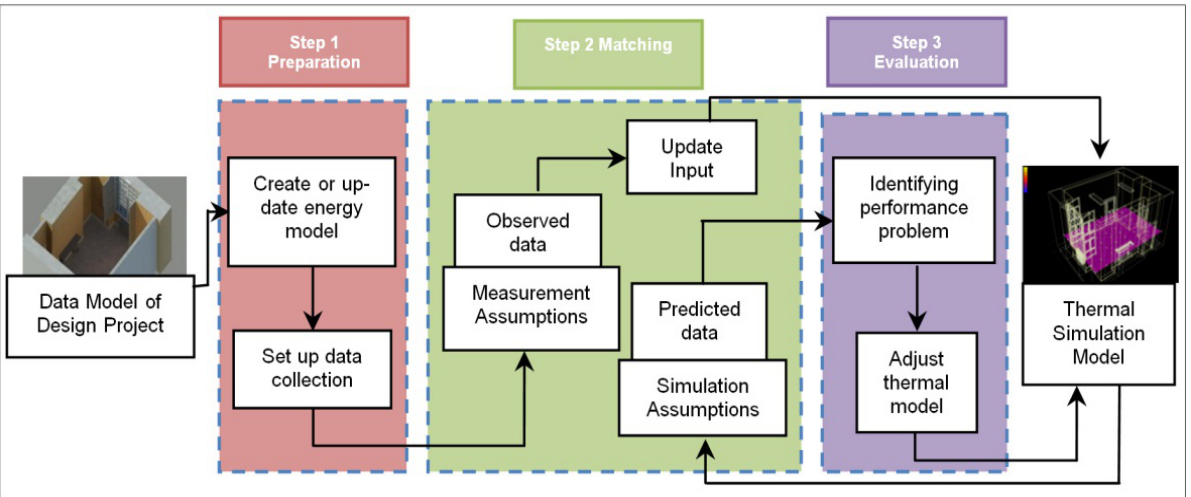
Figure 2. Workflow to produce a thermal simulation